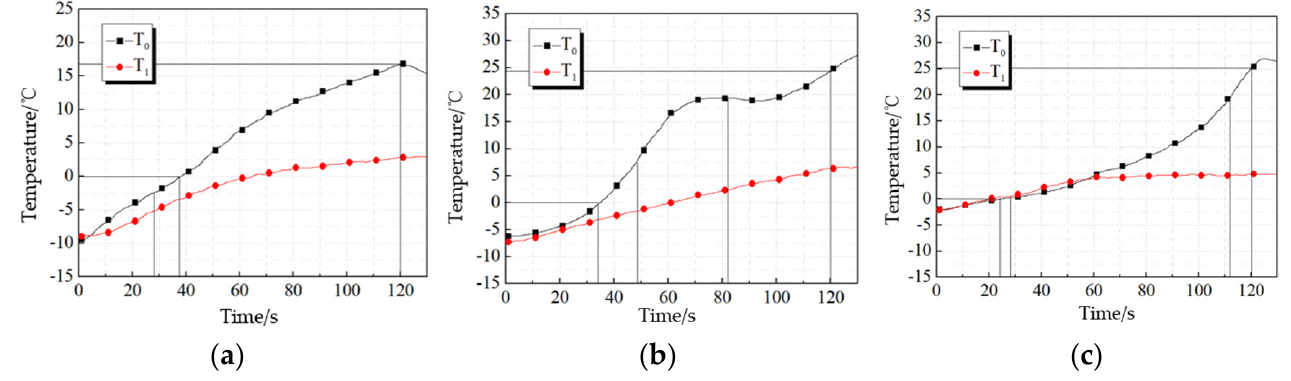
Figure 10. Temperature changes of each specimen at different initial temperatures. ( a ) − 10 ◦ C; ( b ) − 6 ◦ C; ( c ) − 2 ◦